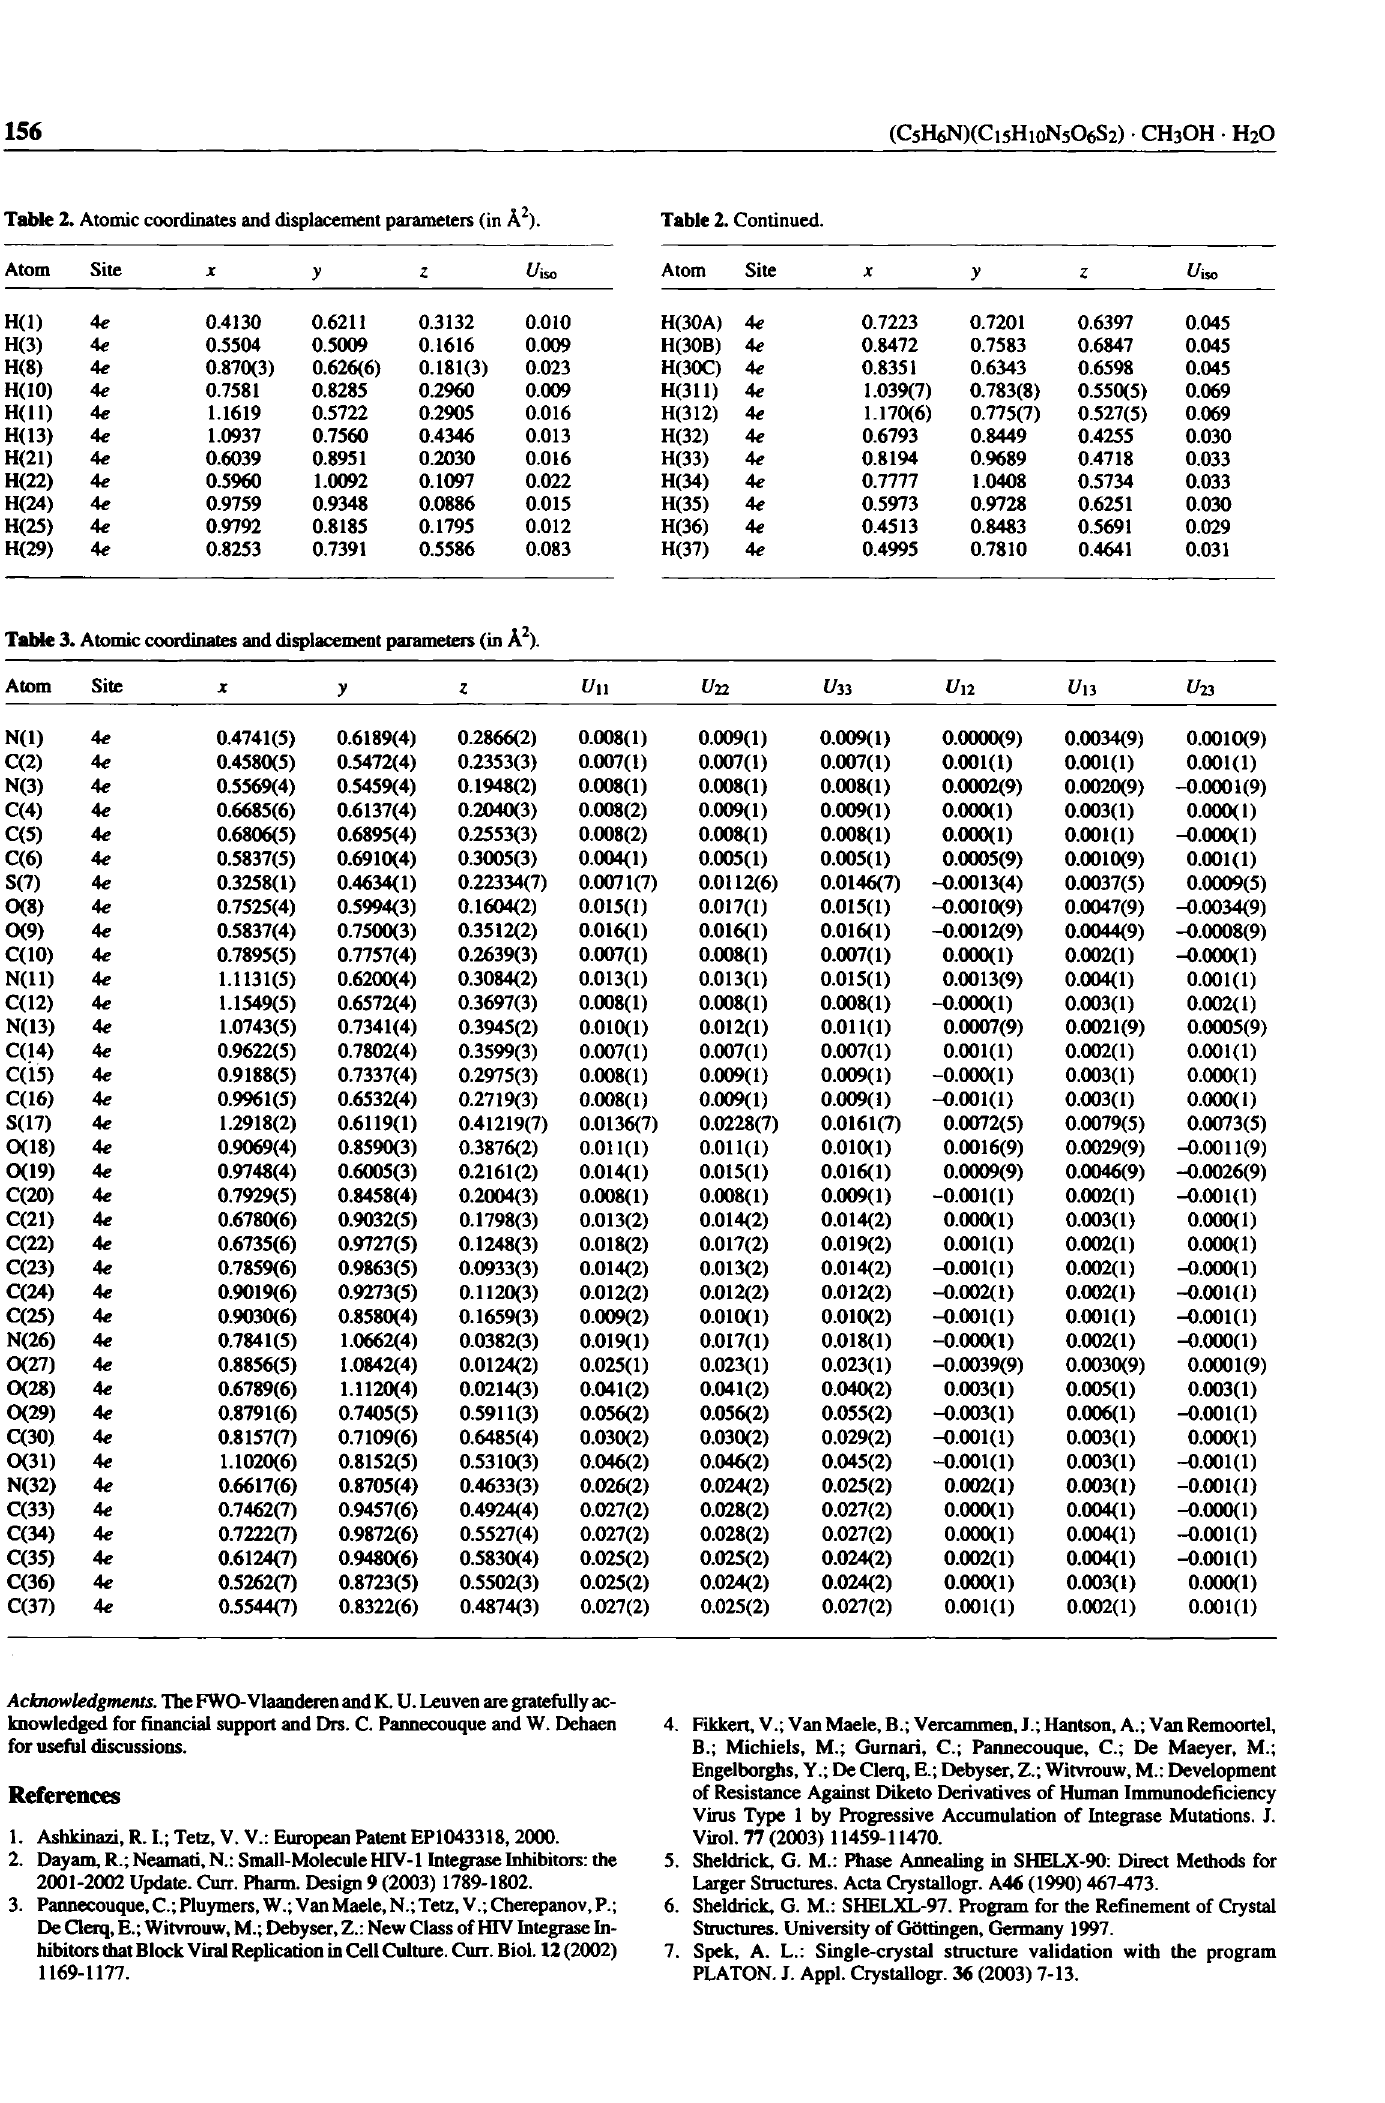
Table 3. Atomic coordinates and displacement parameters (in A 2